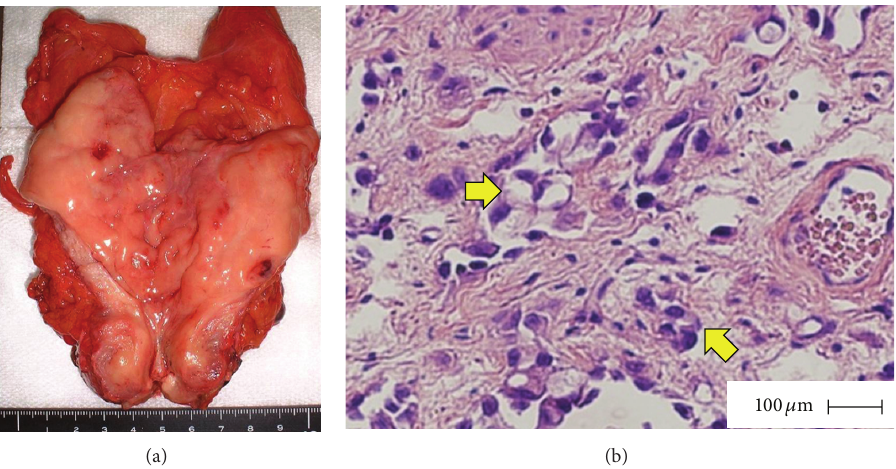
Figure 2: (a) Macroscopic image of resected urinary bladder specimen shows white colored, diffuse nonpapillary tumor. (b) Macroscopic appearance of the urinary bladder tumor shows poorly differentiated adenocarcinoma with multiple signet-ring cells (arrow) (H&E, high- power view). Table 1: Description of all cases of adjuvant chemotherapy regimens used in advanced SRCCU in Japan with more than 6-month followup.